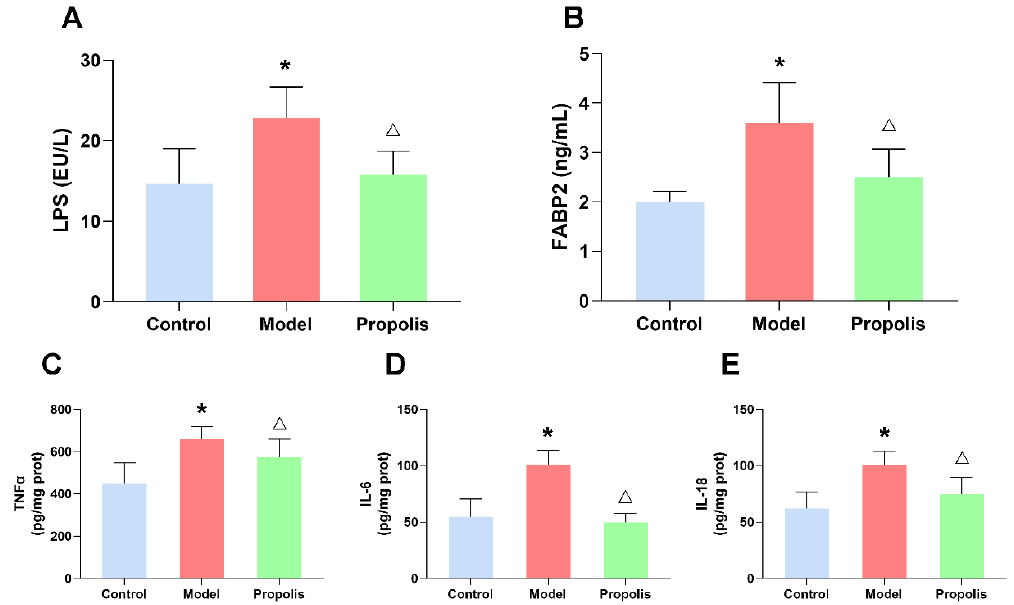
Figure 7. Effects of propolis on alcohol-induced inflammatory reaction. ( A , B ) The serum levels of LPS ( A ) and FABP2 (B). ( C – E ) The levels of inflammatory cytokines in the spleen. TNF- α ( C ), IL-6 ( D ) and IL-18 ( E ). * Denotes p < 0.05 vs. control group; △ p < 0.05 vs. model group.